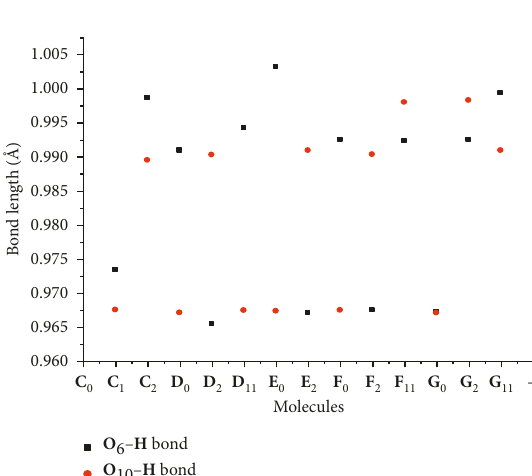
Figure 3: Graphical comparison between O distances at B3LYP/6-311++G(d,p) level in gas phase.